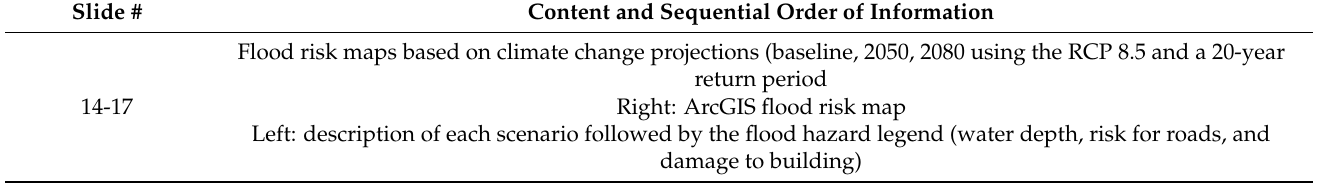
Table 5. Cont. Content and Sequential Order of